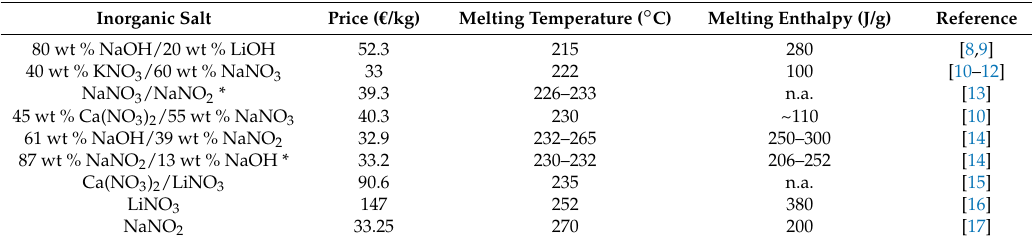
Table 1. Inorganic salt phase change material (PCM) candidates with phase change temperature between 210 ◦ C and 270 ◦ C.